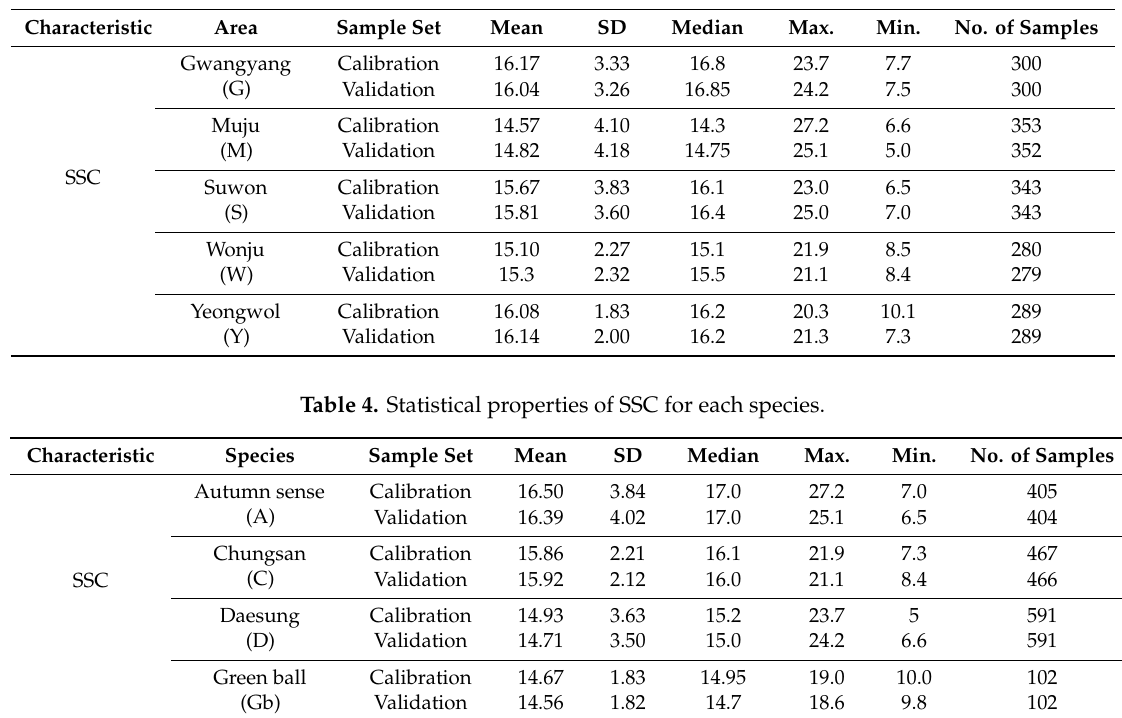
Table 3. Statistical properties of soluble solids content (SSC) in each area.